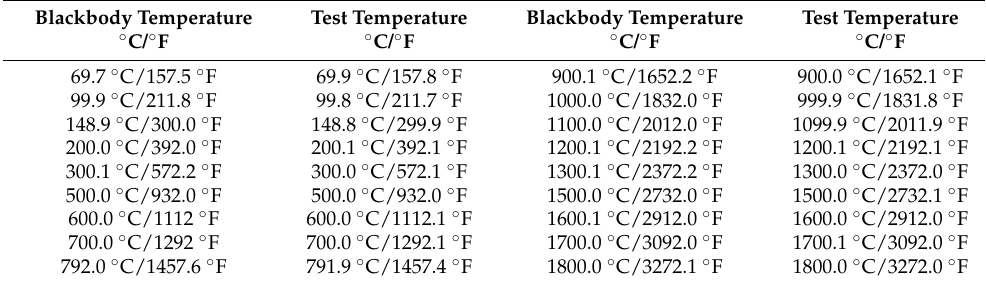
Table 6. Calibration parameters of a high-temperature colorimeter